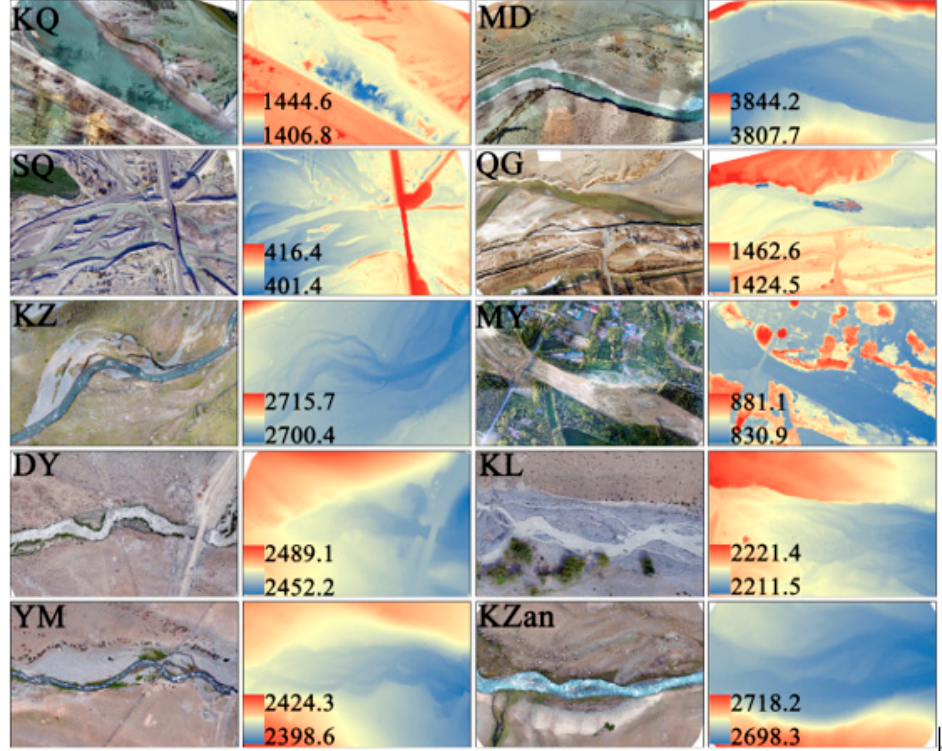
Figure 3. DSM and DOM of the study area. In the same section, DOM is on the left and DSM is on the right. the